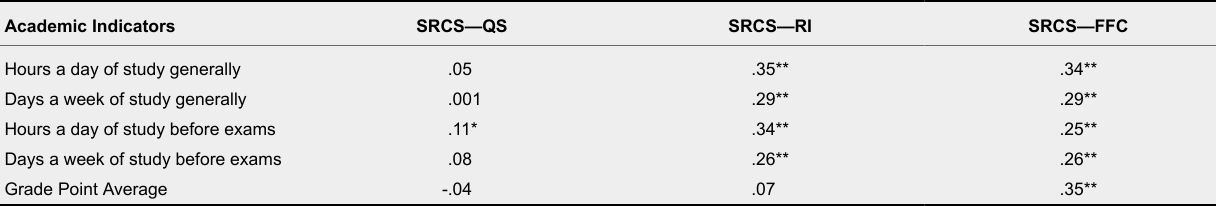
Academic Indicators